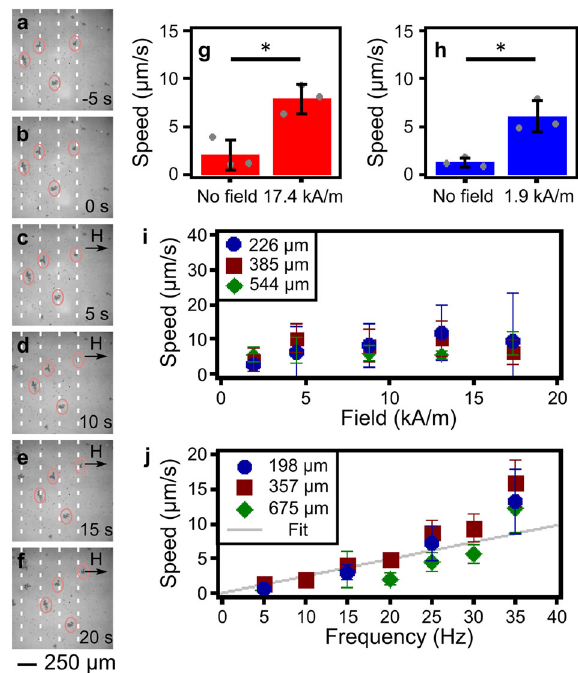
Fig. 5 Demonstration of fl uid movement due to actuation of membrane with graded axle width pro fi le. a , b Still images of tracer beads before and c – f during application of a 15 Hz, 17.4 kA/m fi eld at the time indicated ( fl uid height h = 544 µ m). Ellipses highlight selected bead clusters and dashed lines demarcate 250 µ m steps. g , h Statistical comparison of fl ow speed before and during application of g 17.4 kA/m and h 1.9 kA/m fi elds (15 Hz, h = 544 µ m); * = p < 0.05 (one-tailed paired t -test), data bars are the average fl ow (error bars show standard deviation) from n = 3 separate fi eld applications (individual data points; average fl ow for each fi eld application measured from 50 beads). Effect of i fi eld amplitude (at 15 Hz) and j frequency (at 11.2 kA/m) on fl ow speed at different h . The line in j is a linear fi t to the h = 357 µ m data for frequencies ≤ 20 Hz. Data obtained by calculating the magnitude of the average velocity vector from 58 – 187 beads, correcting for ambient drift by subtracting the average pre- fi eld measurement (error bars derived from the standard deviation of the x - and y -components of the velocity